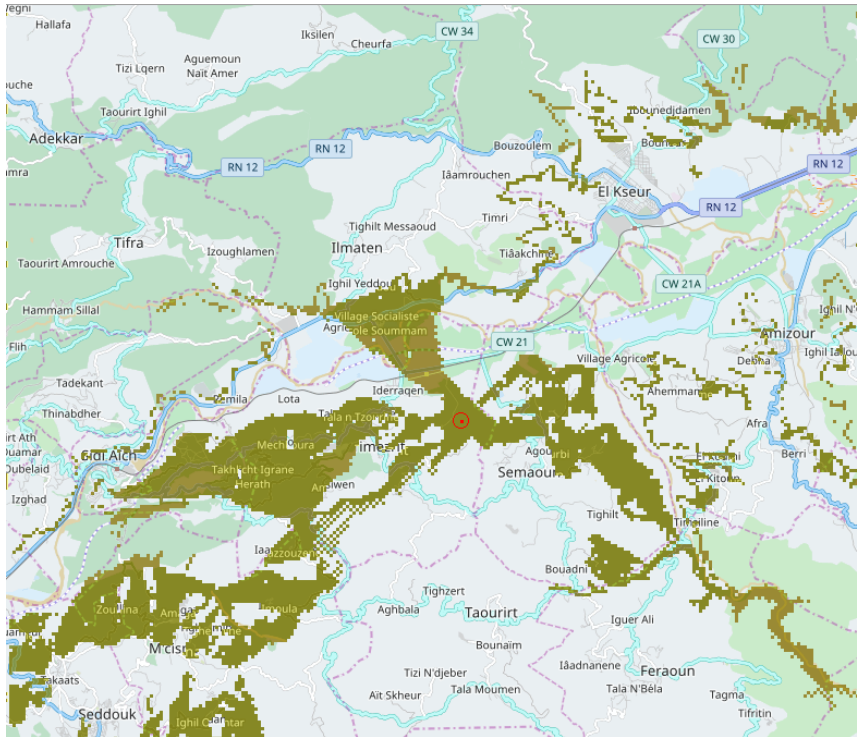
Figure 5. Display of a radio coverage for an emitter (red point), located above the Soummam (36.622141028, 4.799995422), elev:165.0 m. Note that geographic positions are proposed in (lat, long) form compatible with familiar map navigators. Coverage is shown in dark yellow, spreading over 30 km on the zone width. This location was chosen at random, giving a percentage of 32% grid points receiving the long-range